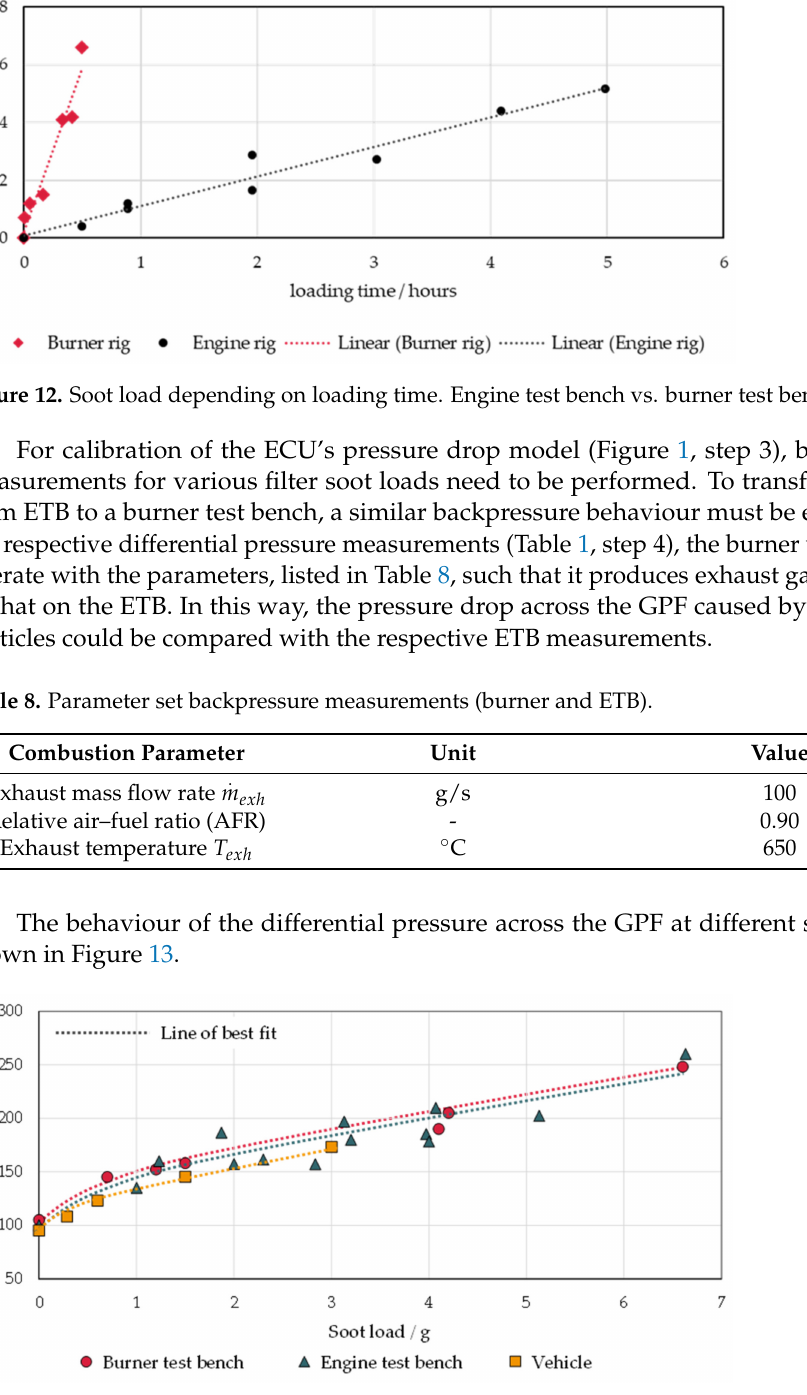
Figure 13. Backpressure behaviour on the burner test bench, engine test bench, and during vehicle